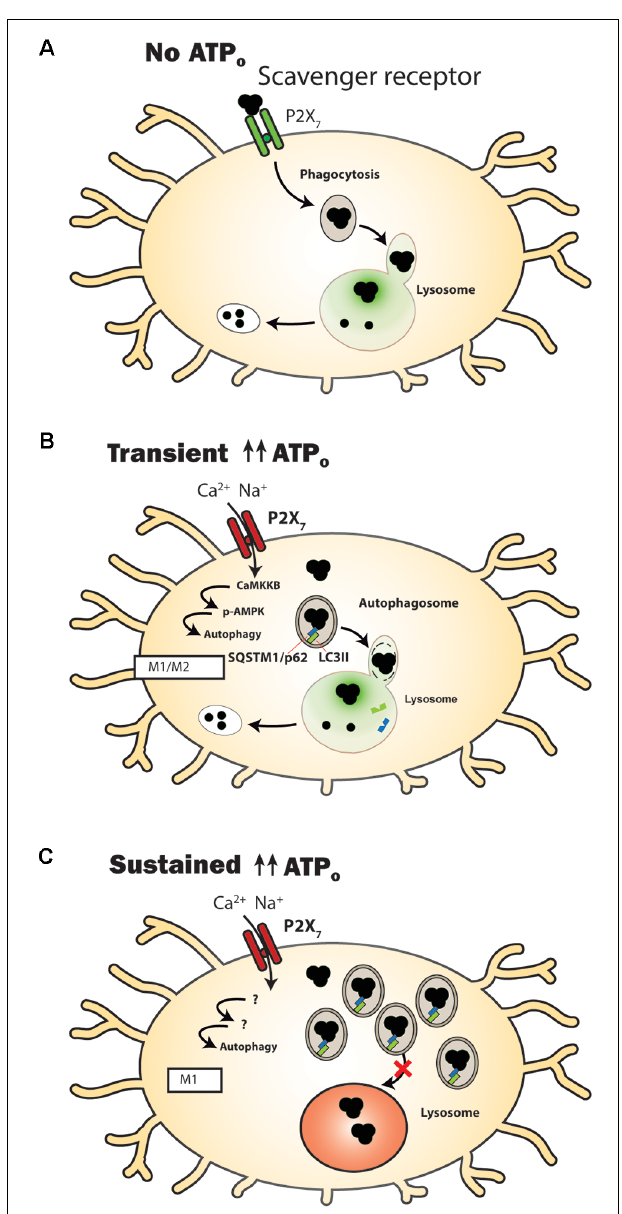
FIGURE 1 | P2X 7 receptor modulation of clearance pathways in microglial cells. (A) Under control conditions when extracellular adenosine triphosphate (ATP) levels (ATP o ) are too low to activate the P2X 7 receptor, it acts as a scavenger receptor to aid in the phagocytosis of extracellular waste. The luminal pH of lysosomes in microglial cells is sufficiently acidic (green) to enable efficient degradative enzyme activity. (B) Following transient stimulation with high concentrations of ATP o , the P2X 7 receptor no longer acts as a scavenger receptor. Autophagy is stimulated, shown by a transient rise in levels of autophagosomal lipid marker microtubule-associated protein 1A/1B-light chain 3-II (LC3-II). Material is degraded and microglia express genes and proteins associated with a mixed M1/M2 activation state. (C) A more prolonged stimulation of the P2X 7 receptor leads to an elevated lysosome pH (red), with autophagosomal contents being delivered extracellularly instead of to the lysosome. Markers of accumulation, including LC3-II (green) and sequestosome-1 (SQSTM1/p62; blue) are elevated. Microglia express genes and proteins associated with an M1 activation